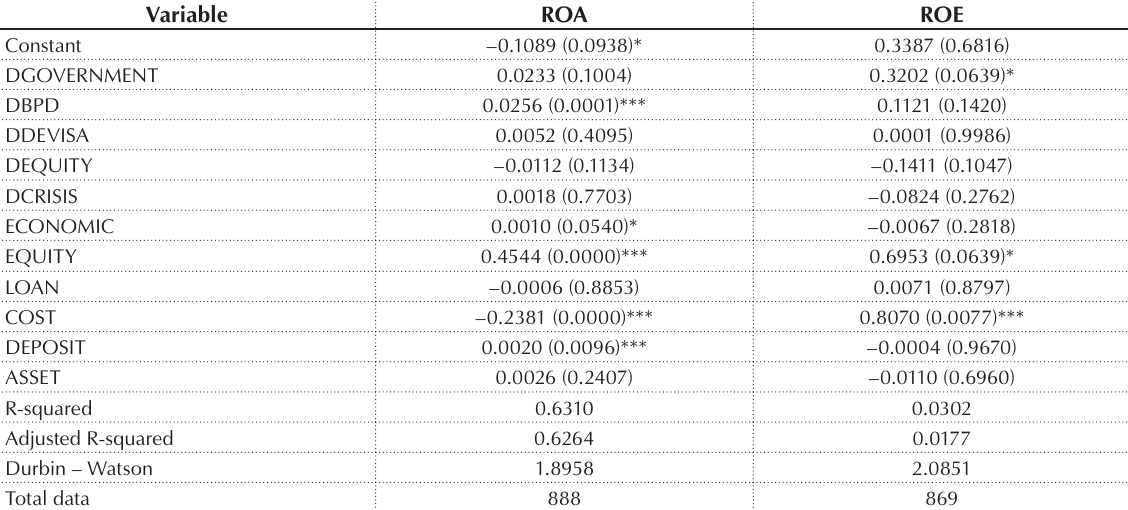
Table (cid:1006). (cid:100)(cid:346)(cid:286)(cid:3)(cid:396)(cid:286)(cid:400)(cid:437)(cid:367)(cid:410)(cid:400)(cid:3)(cid:381)(cid:296)(cid:3)(cid:437)(cid:400)(cid:349)(cid:374)(cid:336)(cid:3)(cid:410)(cid:346)(cid:286)(cid:3)(cid:396)(cid:258)(cid:374)(cid:282)(cid:381)(cid:373)(cid:3)(cid:286)(cid:299)(cid:286)(cid:272)(cid:410)(cid:3)(cid:258)(cid:374)(cid:258)(cid:367)(cid:455)(cid:400)(cid:349)(cid:400)